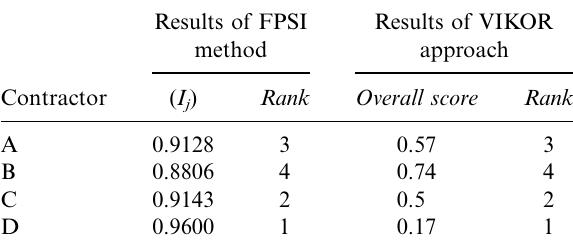
Table 6. The overall preference value